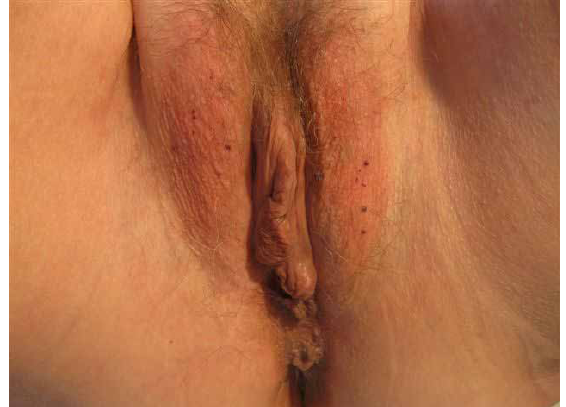
Figure 2. Angokeratomas of the labia